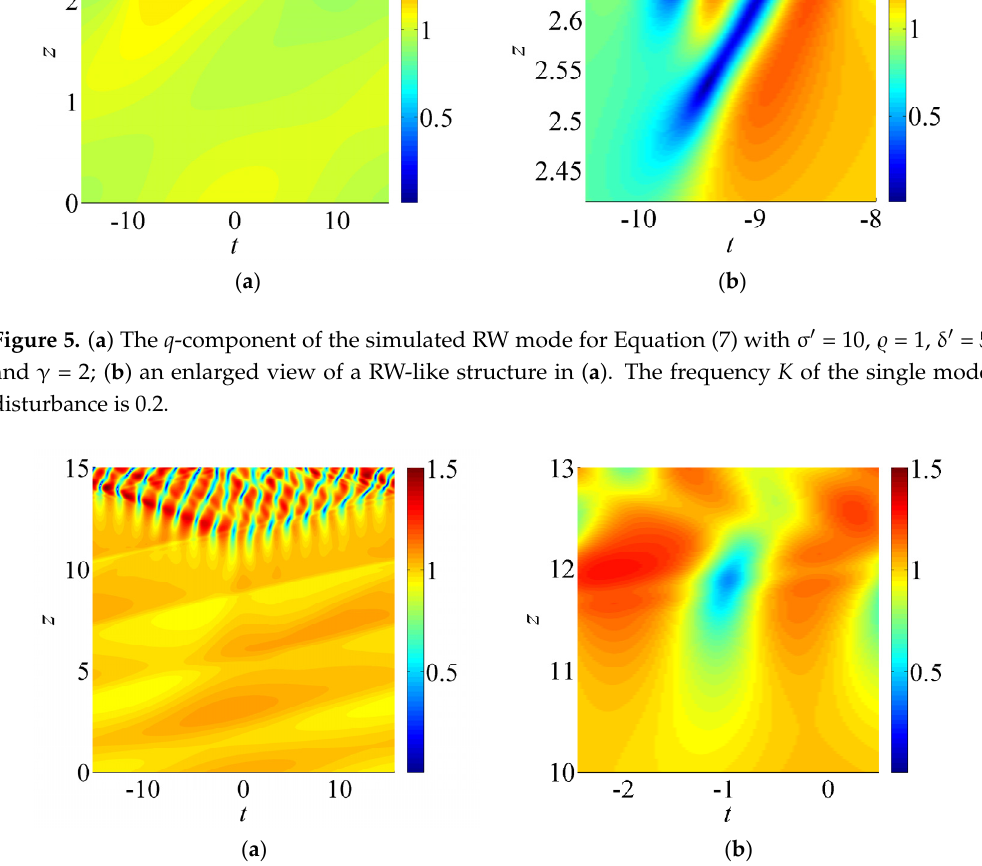
Figure 6. ( a ) The q ‐ component of the simulated RW mode for Equation (7) with σ ’ = 10, ρ = 1, δ ’ = 5 and γ = 0.5; ( b ) an enlarged view of a RW ‐ like structure in ( a ). The frequency K of the single mode disturbance is 0.2.